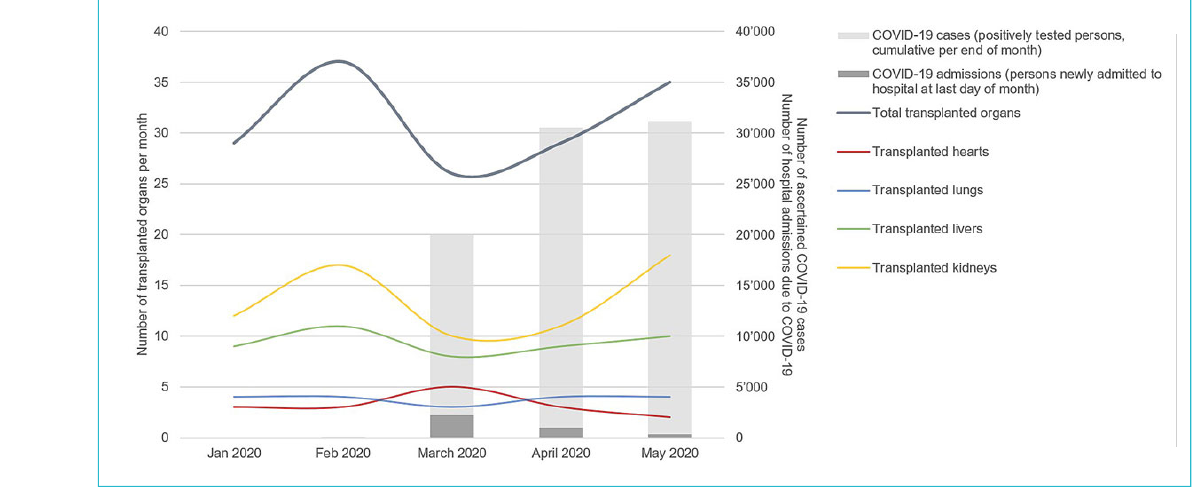
Figure 4: Trends in COVID-19 prevalence, COVID-19 hospital admissions, and solid organ transplants from deceased donors over time in Switzerland. COVID-19 = coronavirus disease